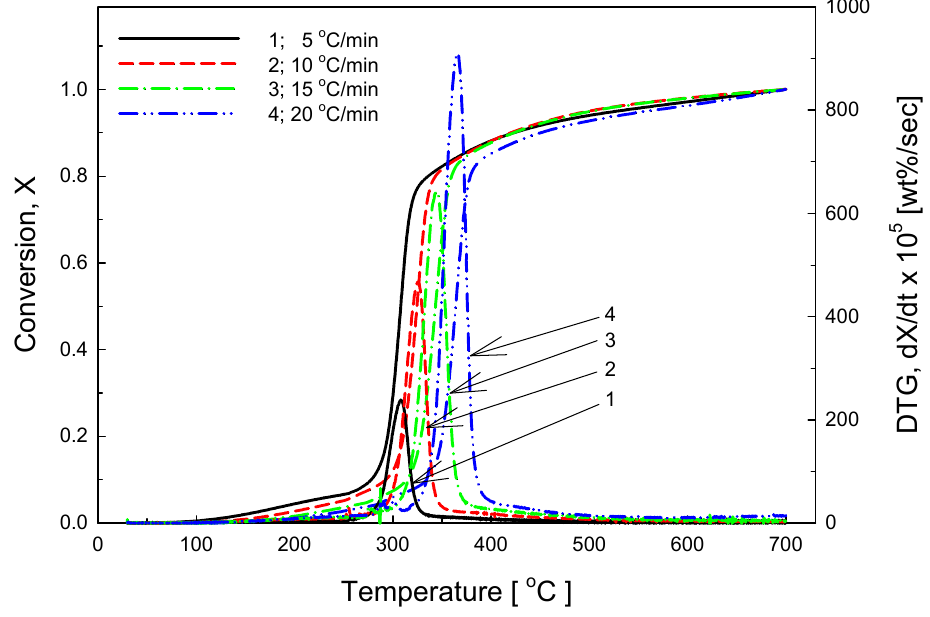
Figure 2. TG and DTG curves of cereal pyrolysis at heating rates of 5, 10, 15, and 20 °C/min.